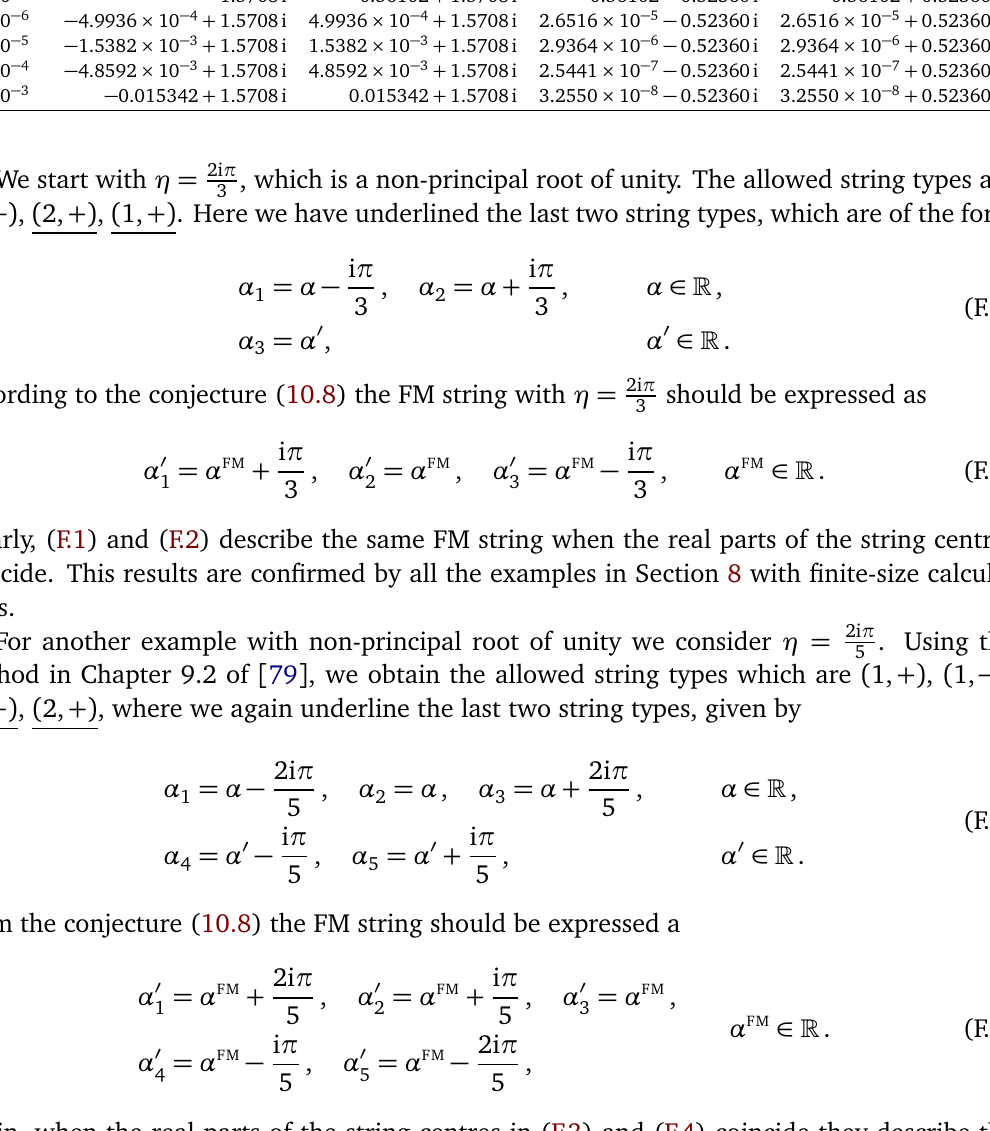
Table 5: The numerical Bethe roots of |{ u η − i π/ 3 u 1 u